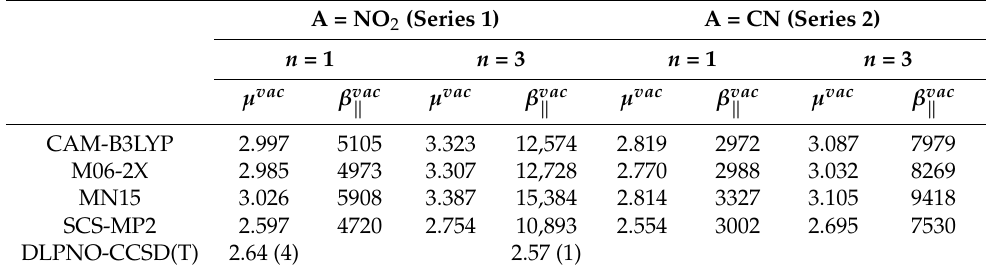
Table 1. Electronic contributions to total dipole moment ( µ ) and average first static hyperpolarizability ( β (cid:107) (0;0,0)) for n = 1, 3 with D = OMe (conformer I ), A = NO 2 /CN. Structures were optimized at the CAM-B3LYP/aug-cc-pVDZ/IEF-PCM(chloroform) level. Properties were calculated in the vacuum and using the aug-cc-pVDZ basis set. All values are given in a.u. A = NO 2 (Series 1) A = CN (Series